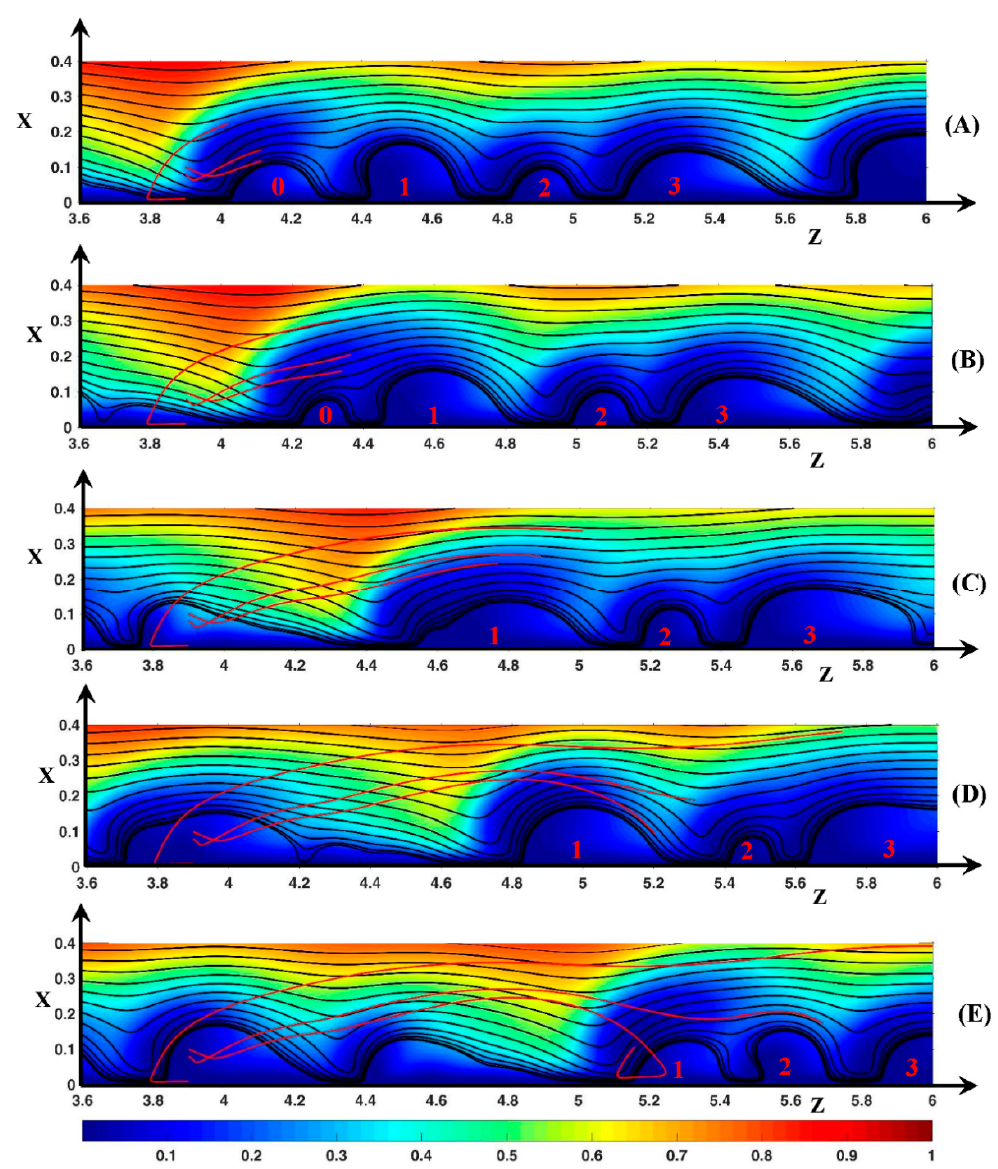
Figure 12. Fluid trajectories. Black lines: static streamlines starting from the inlet. Red lines: dynamic streamlines starting from z o = 3.9 ( x o = 0.01, 0.08, 0.09). Color plot: cation concentration. Red numbers: vortex numbering. Vortex n ◦ 0 is the vortex in which the trajectories source is located at t ’ = 0. ( A ) t ’ = 55; ( B ) t ’ = 85; ( C ) t ’ = 135; ( D ) t ’ = 190; ( E ) t ’ = 245. ∆Φ = 27, ν = 1/3 × 10 − 3 , D ± =